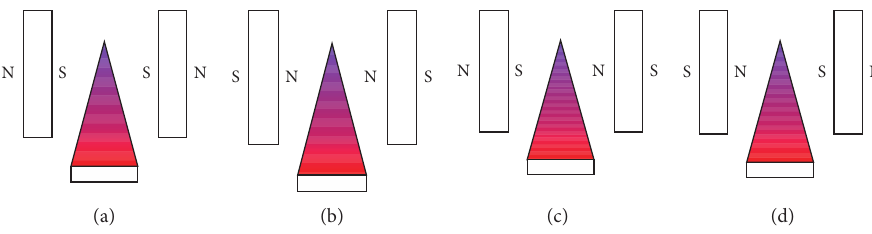
Figure 2: Magnetic field orientation. (a) S pole from the two magnets is facing inside the flame (S-S). (b) N pole from the two magnets is facing inside the flame (N-N). (c) S left magnet pole is facing inside the flame whereas N right magnet pole is facing inside the flame (S-N). (d) N left magnet pole is facing inside the flame whereas S right magnet pole is facing inside the flame (N-S).